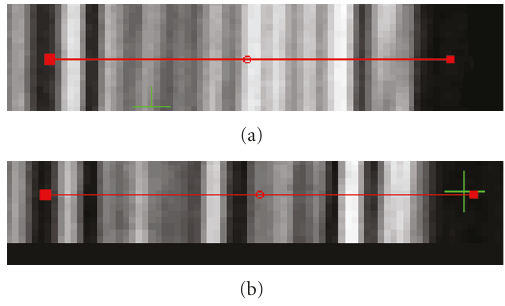
Figure 3: Preprocessing of the CT data. In (a) the original image can be seen. In (b) the result of subtracting the eroded image from the original image is shown.